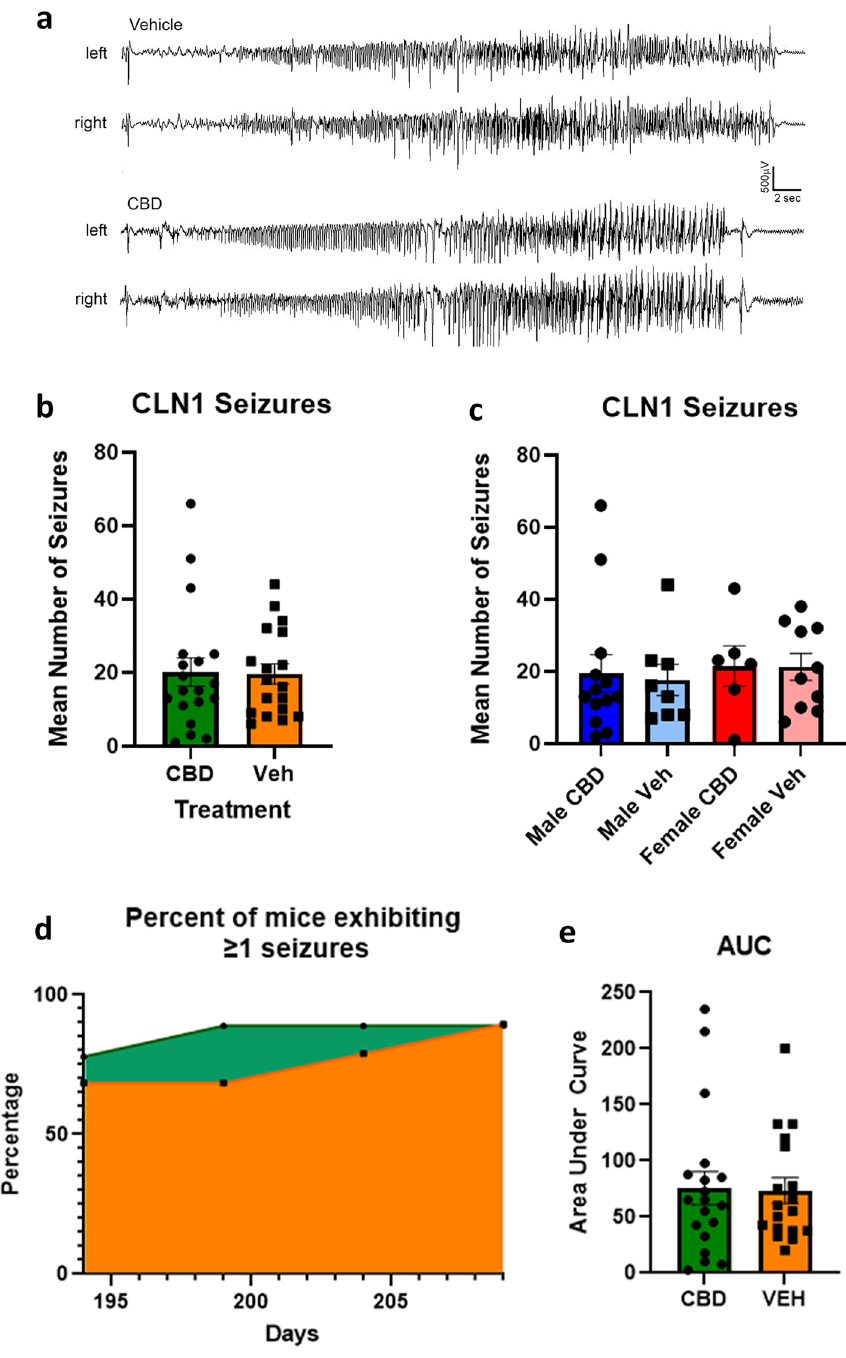
Figure 5. Chronic treatment with cannabidiol does not affect seizures in Cln1 −/− mice. ( a ) EEG tracings during seizures are displayed for Cln1 −/− mice treated with either vehicle or CBD; readings from electrodes placed on the left and right side of the skull are shown. Mice treated with CBD or vehicle exhibited similar numbers of seizures, and this was true within both males and females when analyzed separately ( b , c ). A similar proportion of Cln1 −/− mice exhibited seizures across the observation window regardless of treatment, as shown in the area under the curve analysis ( d , e ). Data shown are means ±